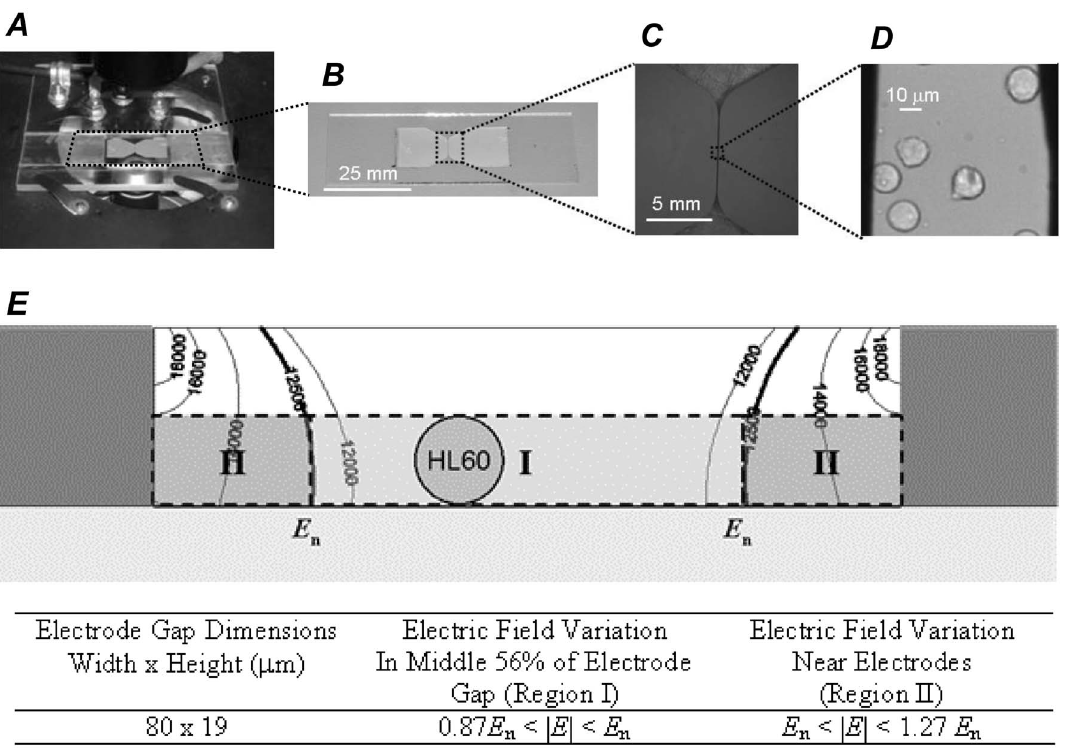
Figure 3. A microcuvette with a microchannel was used to expose cells to PEFs while imaging them over time under fluorescence and bright-field microscopy. A : The microcuvette was designed to be placed on the platform of an inverted microscope. B – D : The microcuvette has an 80 mm microchannel where cells can be exposed to PEFs between two parallel electrodes and monitored under microscopy. E : FEM analysis results showing field heterogeneity within the microcuvette’s microchannel when the electrodes are excited with a nominal electric field value of E n =12.5 kV/cm (as calculated by the excitation voltage divided by the electrode gap). HL60 s resting in region I would be exposed to 0.87 E n to E n while cells resting in region II would be exposed to E n to 1.27 E n . However, because of the steep field gradient in region II, only cells in region I were analyzed for this study. Thus, for a given experiment, the range in PEF intensities to which a given cell was exposed was known. Part E was adapted from Kennedy et al. [18] with authors’